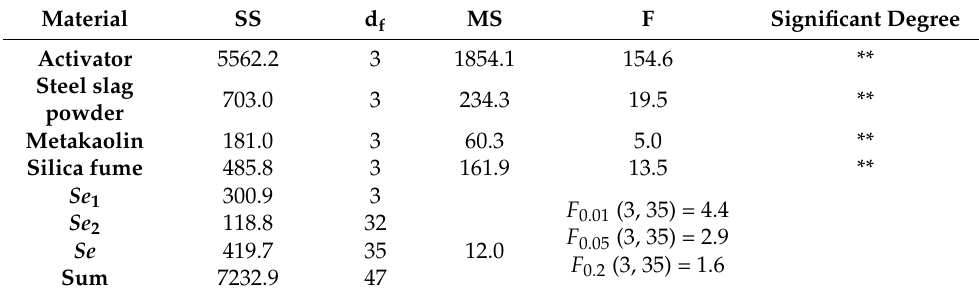
Table 7. Variance analysis of compressive strength.